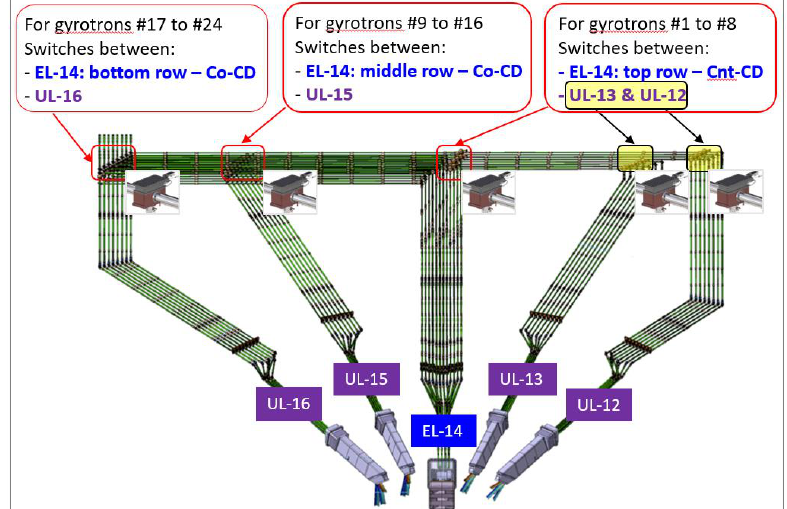
Fig. 4 : Gyrotron distribution of 24MW system – 56 beamlines. Five sets of switches along the transmission lines bring flexibility to the EC system